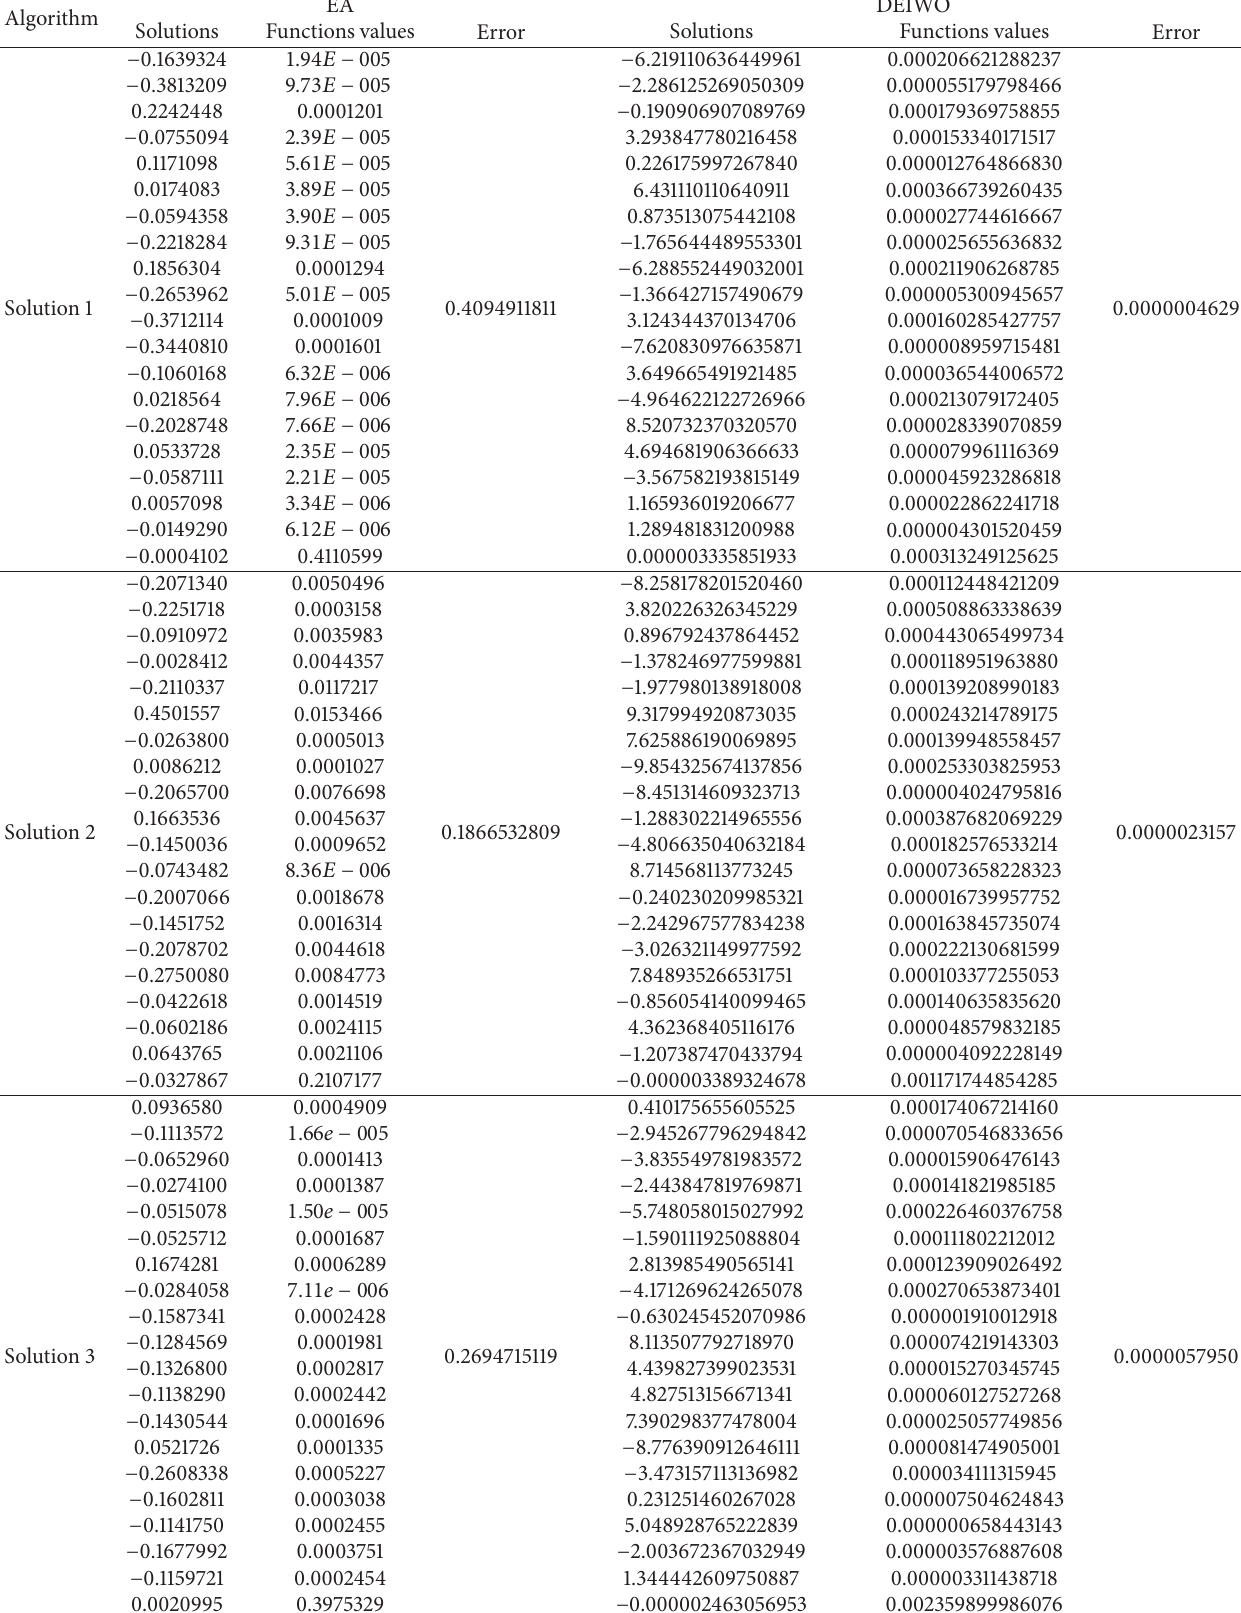
Table 11: Comparison of results for economics modeling application